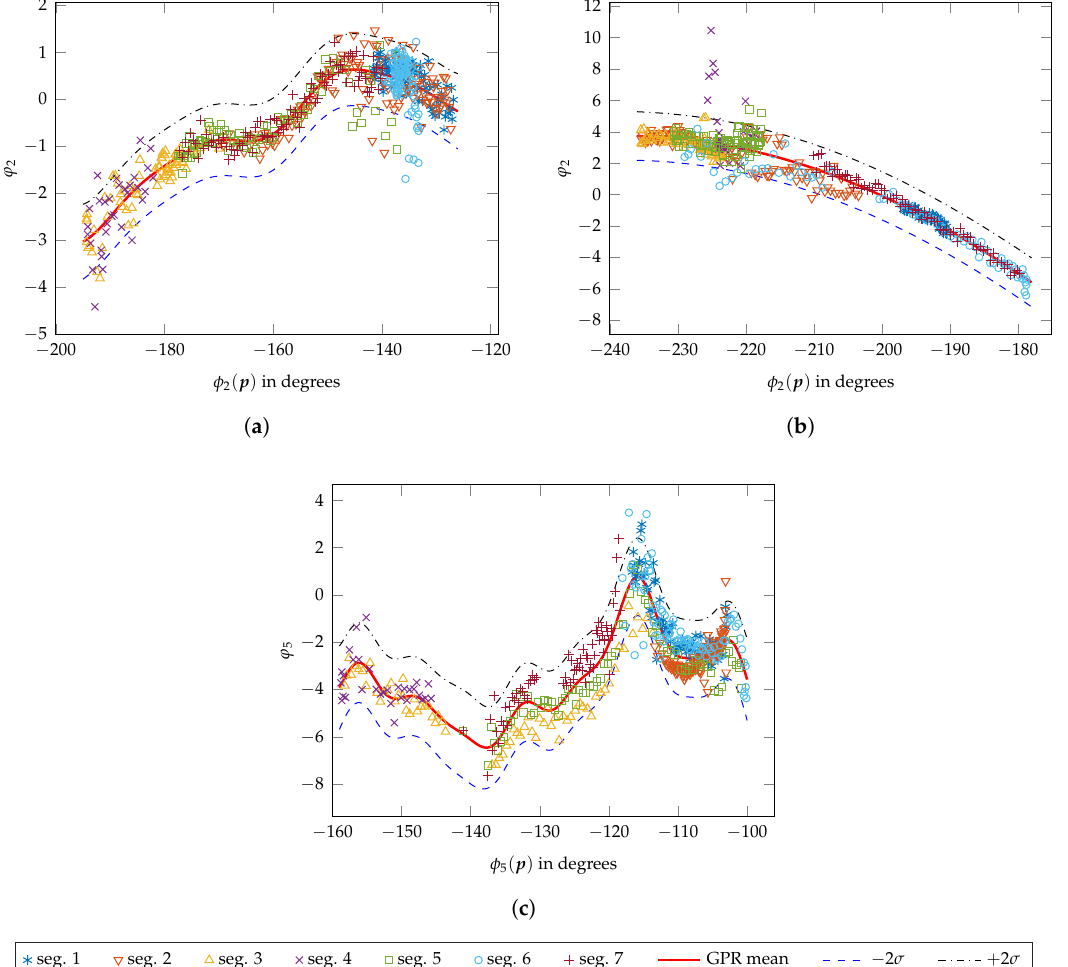
Figure 6. GP regression of the SMC phases for ( a ) the SMC amplitude of VA at a ( 1 ) anchor 1 (east plaster board wall), ( b ) the SMC amplitude of VA at a ( 2 ) (east plaster board wall), ( c ) the SMC amplitude of VA at a ( 1 )